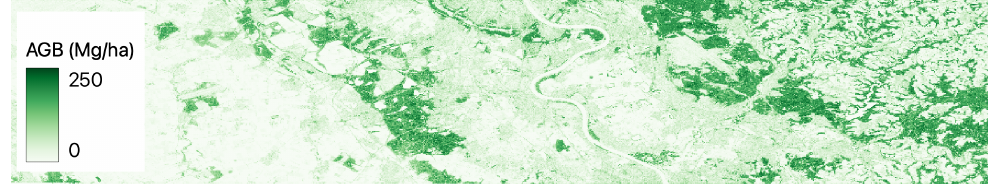
Figure 6. Predictions of AGB using the machine learning approach [14] in Central